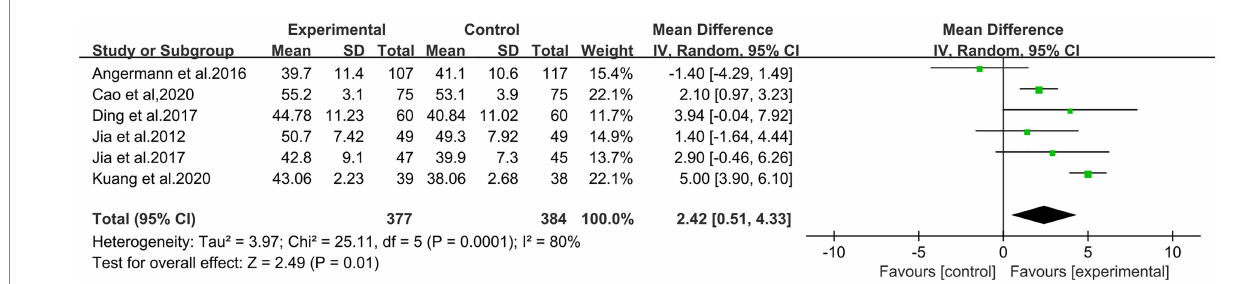
FIGURE 4 Meta-analysis for comparison of LVEF between the experimental and control groups.